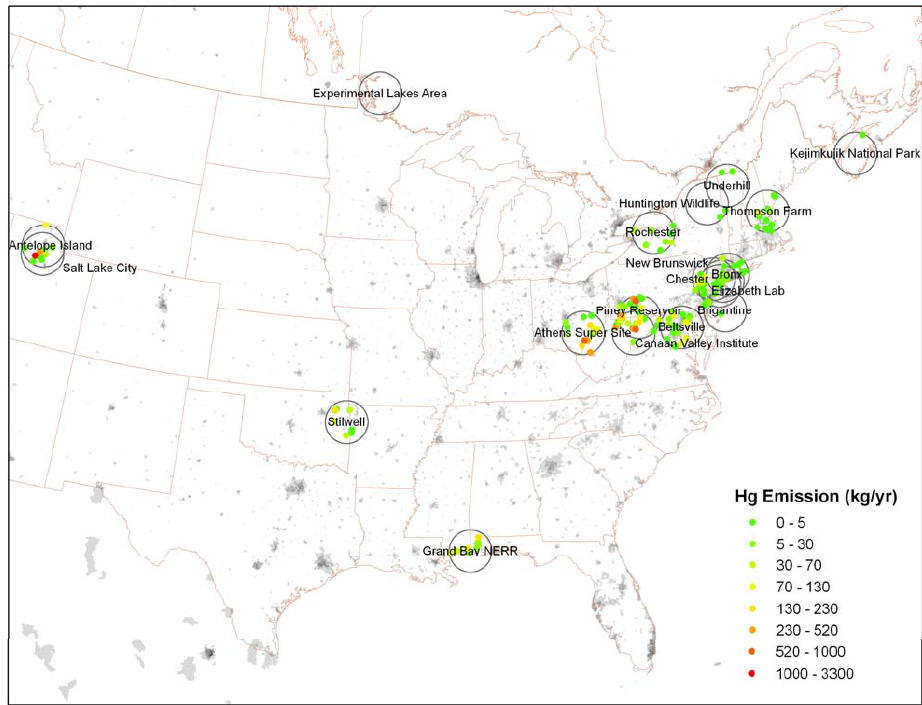
Fig. 1. Locations of the AMNet sites where Hg dry deposition were estimated. Also shown are Hg point source emissions with a 100km circle of each